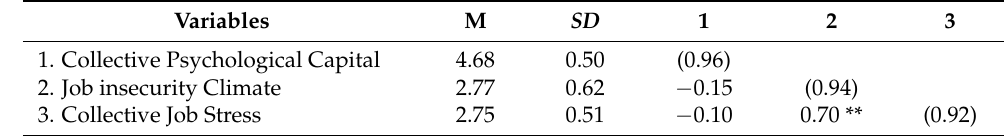
Table 2. Means, standard deviations, and correlations (branch level: N =